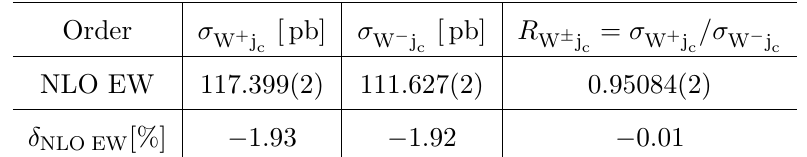
(cid:0) (cid:1) for pp α s α 3 →